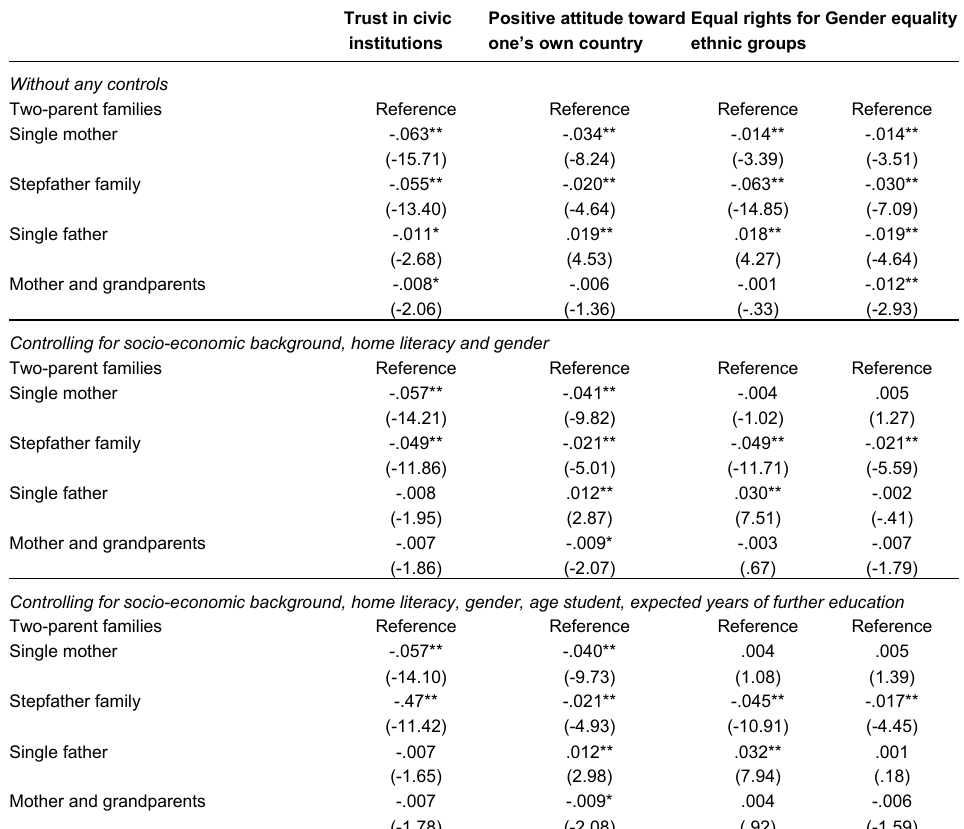
Table 1 : Societal attitudes of 13- and 14-year-old native students in different family forms (with the two-parent family as the reference group). OLS regression standardized coefficients and t -values in